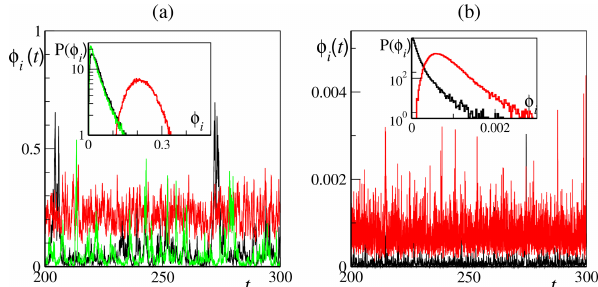
Figure 5. Time trace and probability distribution of CLV instan- taneous projection in the X subspace for h = 1 / 4 and b = 10 and K = 36 and J = 10. (a) Slow-bundle vectors, i = 110 (black line), i = 122 (red line, the 0-CLV) and i = 160 (green line). In the in- set are the corresponding probability distributions of the three CLV time traces. (b) For two other CLVs with negligible X projection, first vector (black line) and 255th vector (red line). In the inset are corresponding probability distributions of the two CLV time